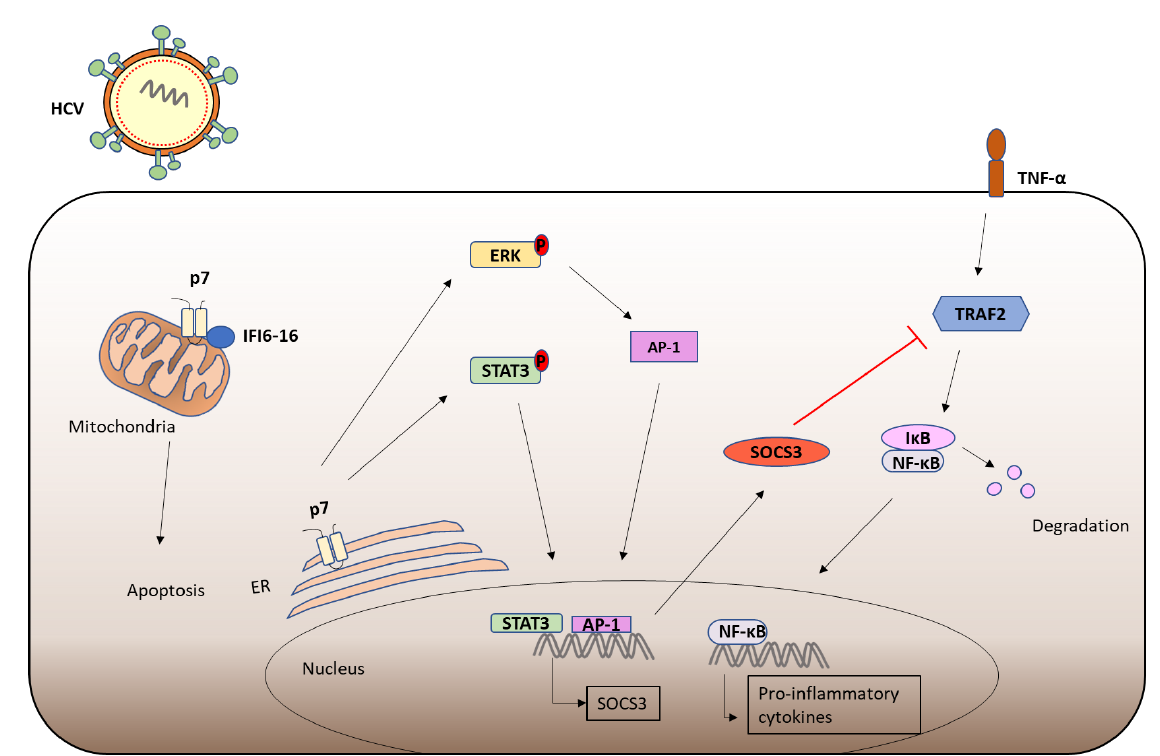
Figure 4. Immunomodulation by HCV p7. The viroporin p7 has recently been shown to contribute to immune evasion during HCV infection. p7, which localizes to the ER, has been shown to induce ERK and STAT3 phosphorylation which leads to subsequent SOCS3 upregulation. SOCS3 has been shown to attenuate TNF- α mediated NF- κ B activation by targeting the signaling intermediate TRAF2. Thus, p7 inhibits the induction of NF- κ B regulated genes, including pro- inflammatory cytokines. HCV p7 is also expressed at the mitochondria where it inhibits IFI6-16 leading to destabilization of the mitochondrial membrane and the induction of